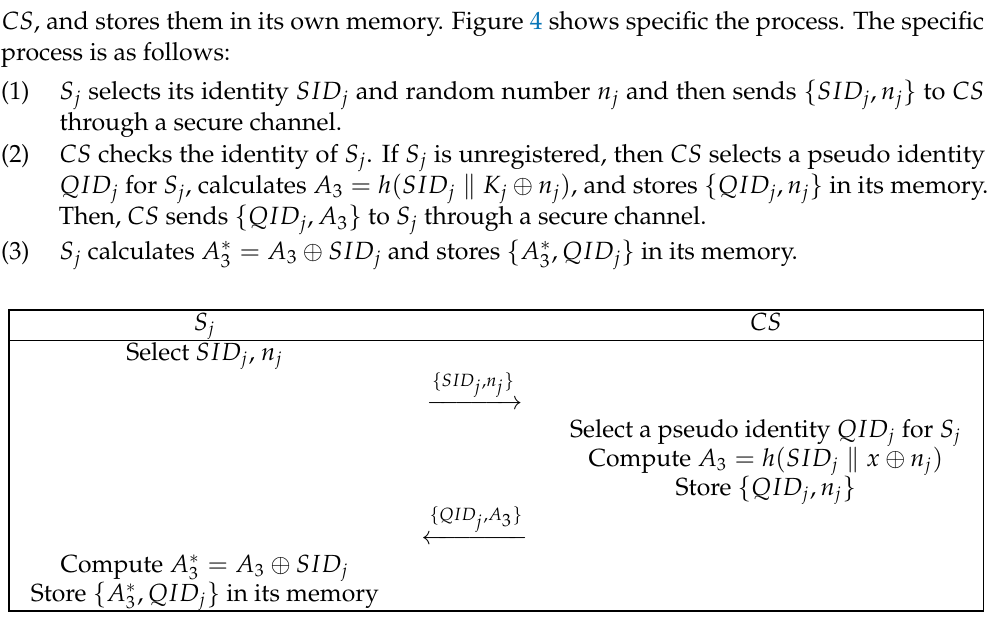
Figure 4. Cloud server registration